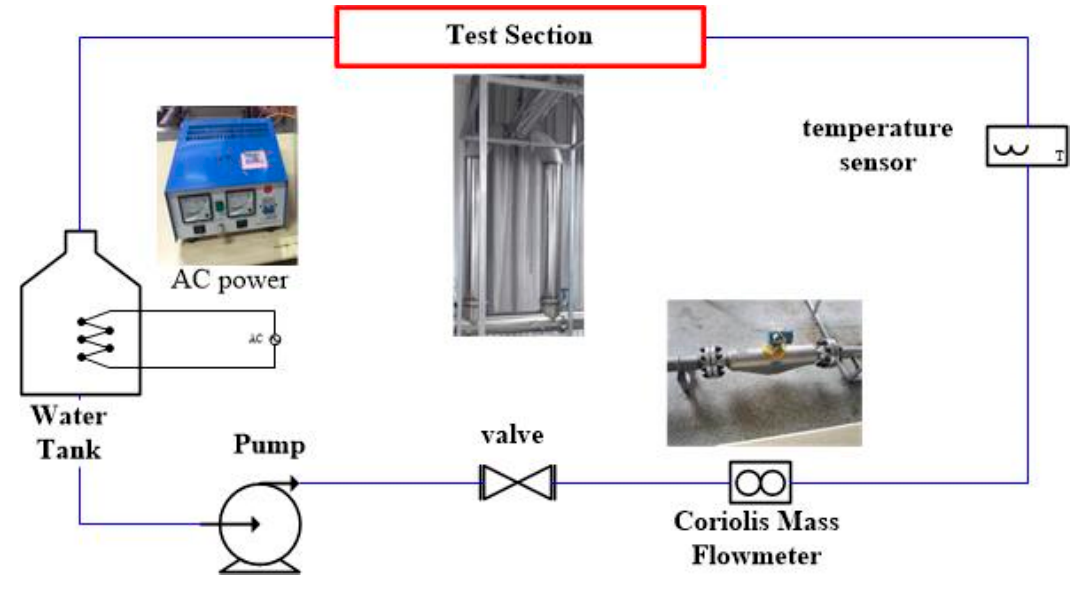
Figure 1. Test system of parallel pipeline flow distribution.